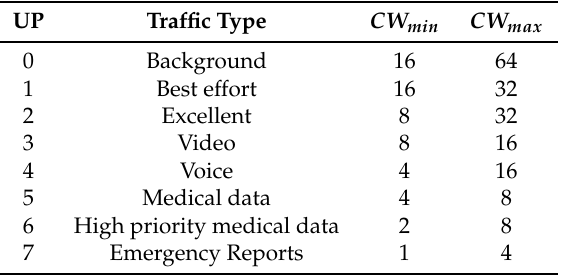
Table 1. Contention window bounds for IEEE 802.15.6 CSMA/CA.